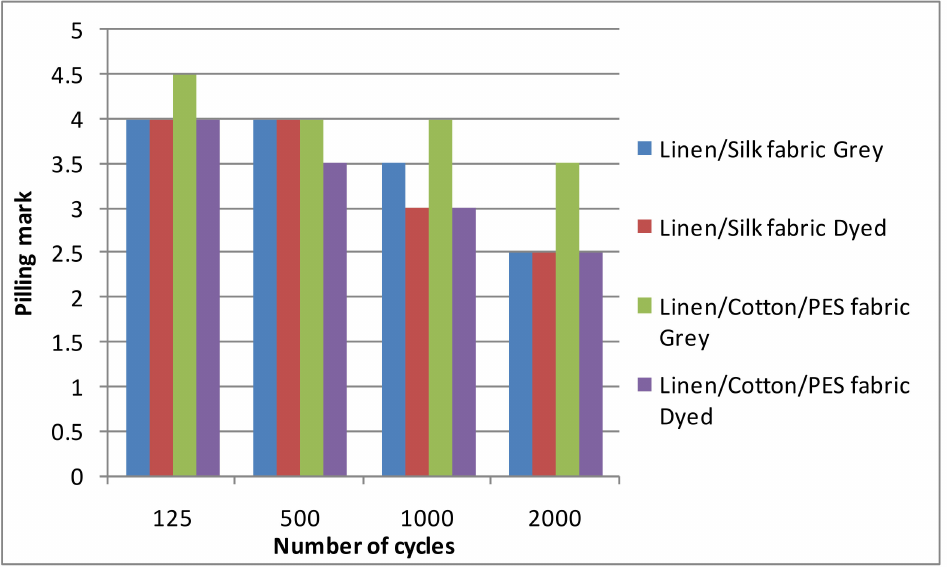
Figure 6. Pilling marks of grey and dyed linen/silk fabrics with additional mechanical finishing.